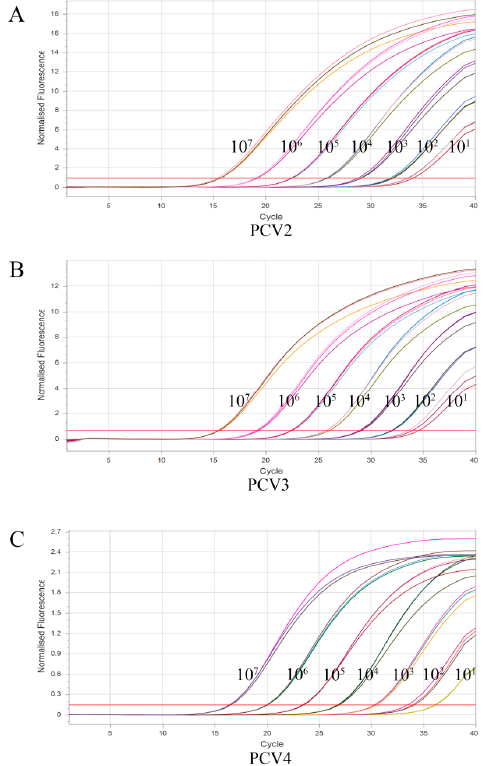
Figure 3. Sensitivity analysis of multiplex TaqMan qPCR. ( A ), sensitivity analysis of PCV2; ( B ), sensitivity analysis of PCV3; ( C ), sensitivity analysis of PCV4.